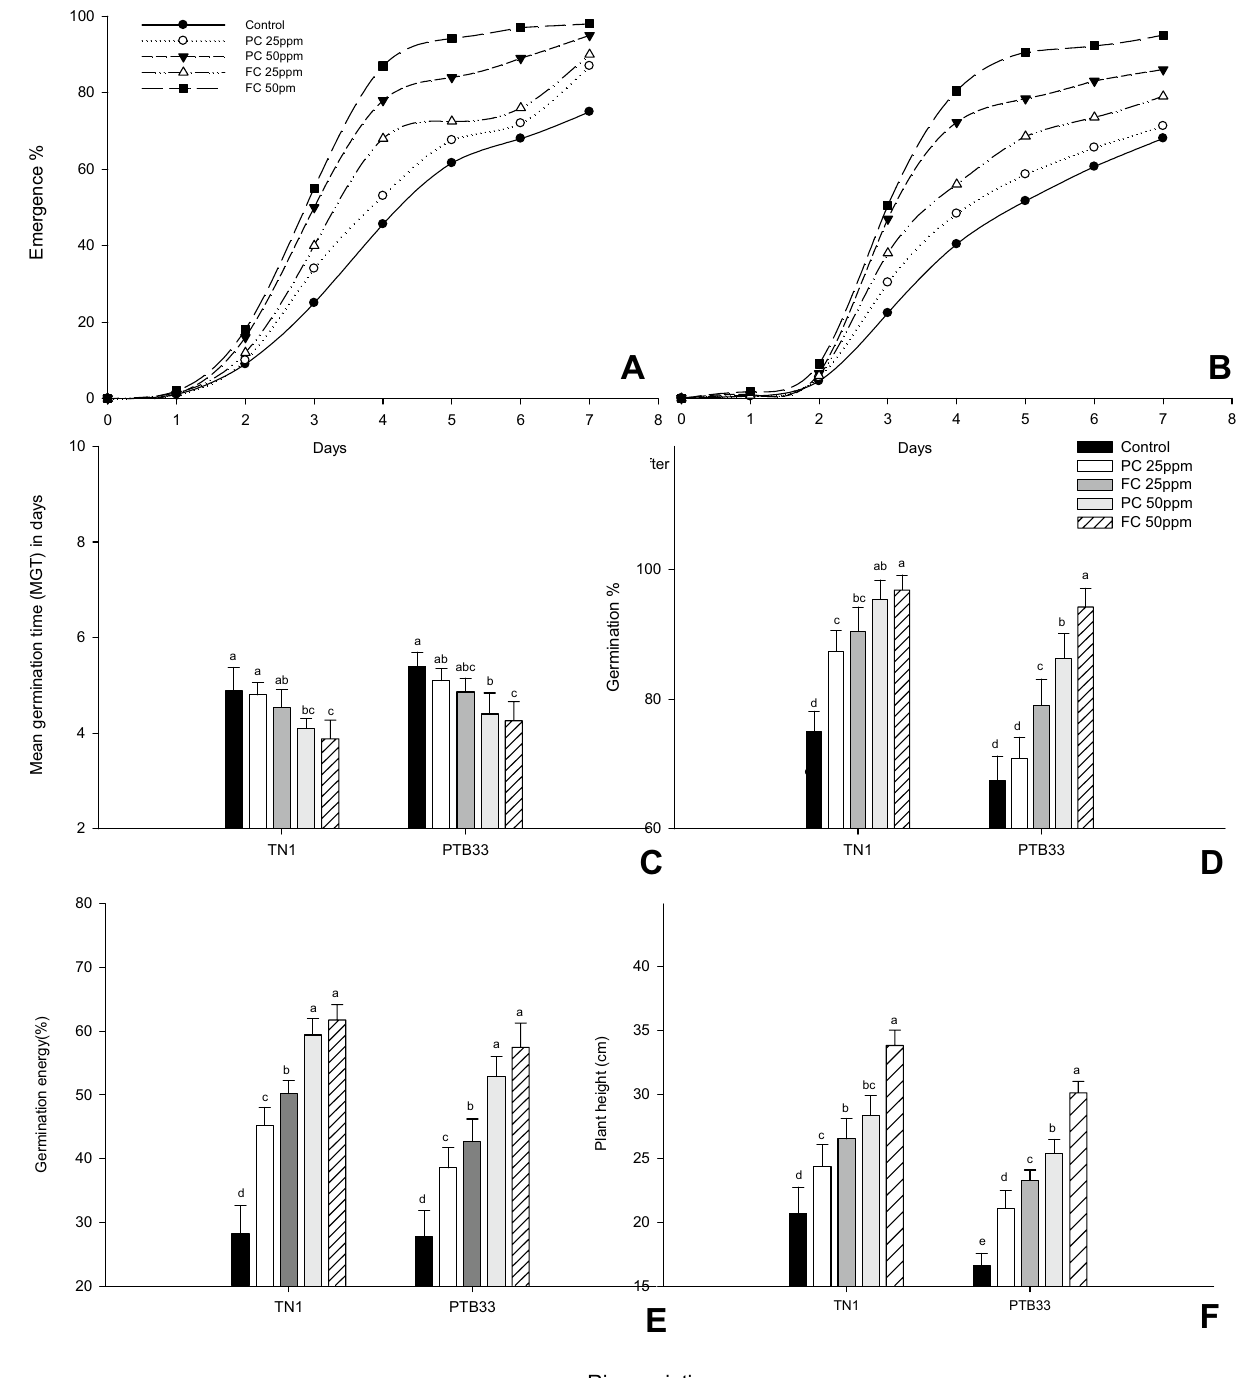
Figure 3. Percentage of emergence of rice varieties treated with fungal chitosan (FC) or the product chitosan (PC) across 12 day period, post treatment ( A —TN1, B —PTB33) (± SEM with five replication) and the. Effect of fungal chitosan (FC) and product chitosan (PC) on mean germination (MGT) days ( C ), percentage of germination ( D ), germination energy ( E ) and plant height ( F ) of rice seeds (± SEM with five replication) (with in the bars denoted by a different letter are significantly different at P ≤